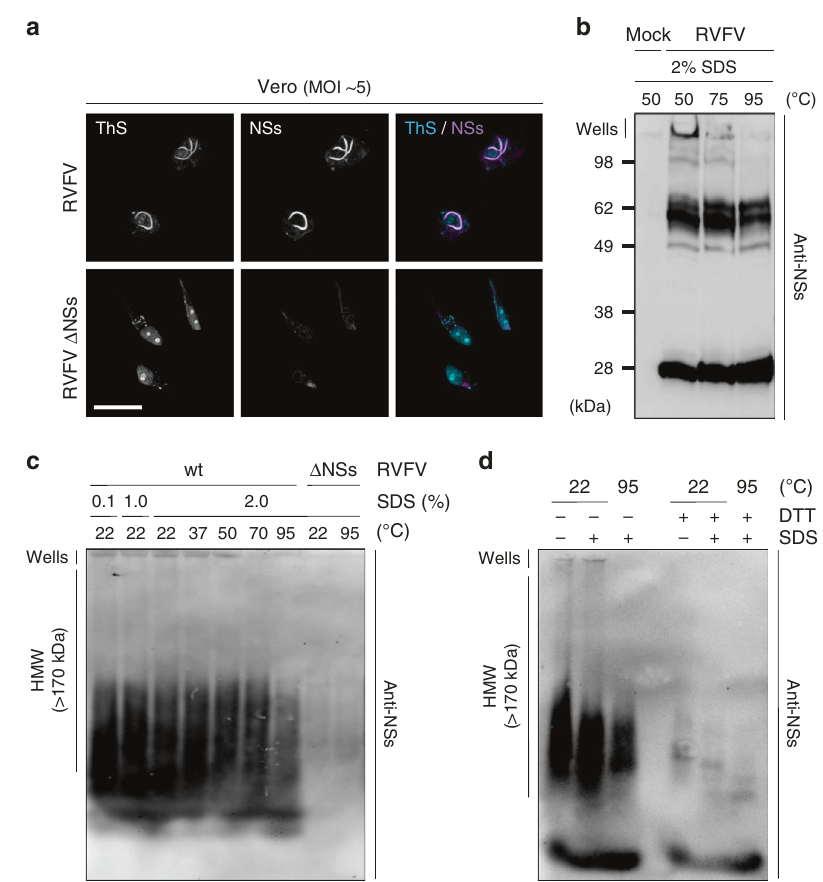
Fig. 2 NSs aggregates exhibit amyloid properties. a Vero cells were infected with RVFV and RVFV Δ NSs for 16 h. Infected cells were permeabilized with a Triton X-100-based buffer and then stained with the amyloid-binding dye Thio fl avin-S (ThS, blue) and Abs against NSs (purple) before analysis by confocal microscopy. Images are representative of three independent experiments. Scale bar, 20 µ m. b Vero cells were exposed to RVFV (MOI ~5) and nuclei isolated 16 h pi before being subjected to 2%-SDS treatments and incubated at the indicated temperatures for 15 min. Nuclear extracts were analyzed by 12.5% SDS-PAGE without stacking gel, and under nonreducing conditions followed by WB with Abs against NSs. Results are representative of three independent experiments. c Vero cells were infected with RVFV at a MOI of 5 for 16 h and lyzed. Cell lysates were then subjected to increasing amounts of SDS and incubated at the indicated temperature for 5 min. Proteins were analyzed by 1.5% semi-denaturing detergent-agarose gel electrophoresis (SDD- AGE) followed by capillary transfer and immunoblotting against NSs. Experiments were repeated independently three times with similar results. d Total lysates of Vero cells infected at a MOI of 5 for 16 h were treated with 10 mM DTT and 2% SDS before being incubated at the indicated temperatures for 5 min. Samples were subsequently analyzed by 1.5% SDD-AGE and WB against NSs. HMW, high molecular weight; wt, wild type. Results are representative of three independent